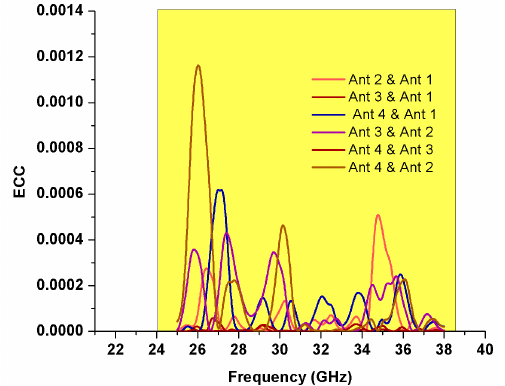
Figure 13. Envelope Correlation Coefficients (ECCs) between some adjacent antenna-elements.